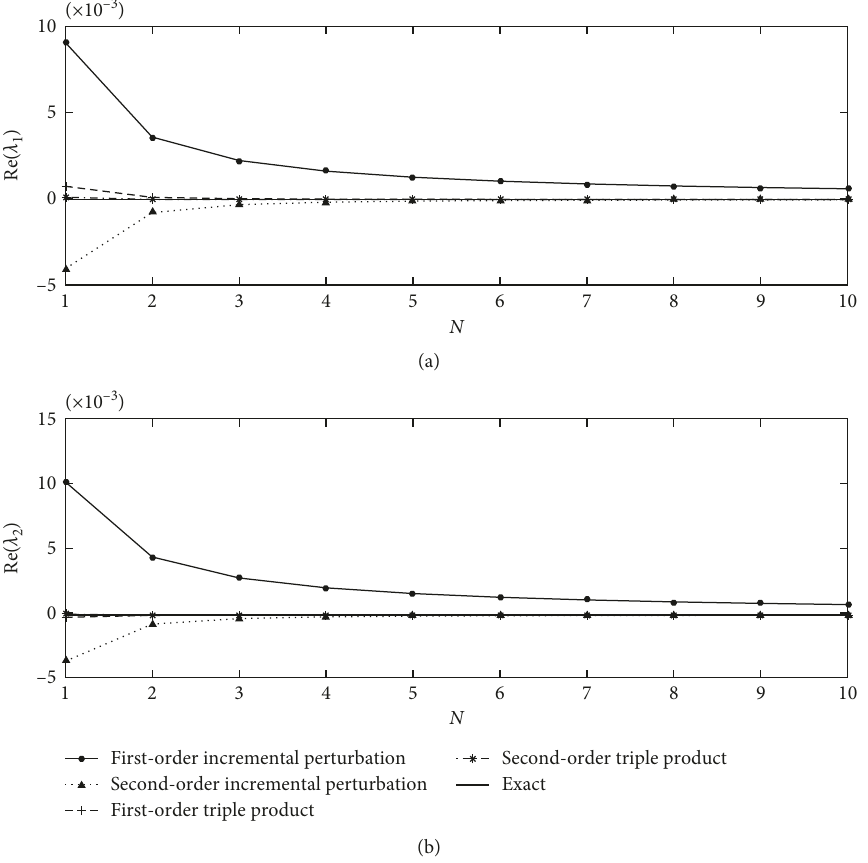
Figure 8: The real parts of the approximate eigenvalues of the two-degree-of-freedom gyroscopic system as a function of N for σ � 1 .